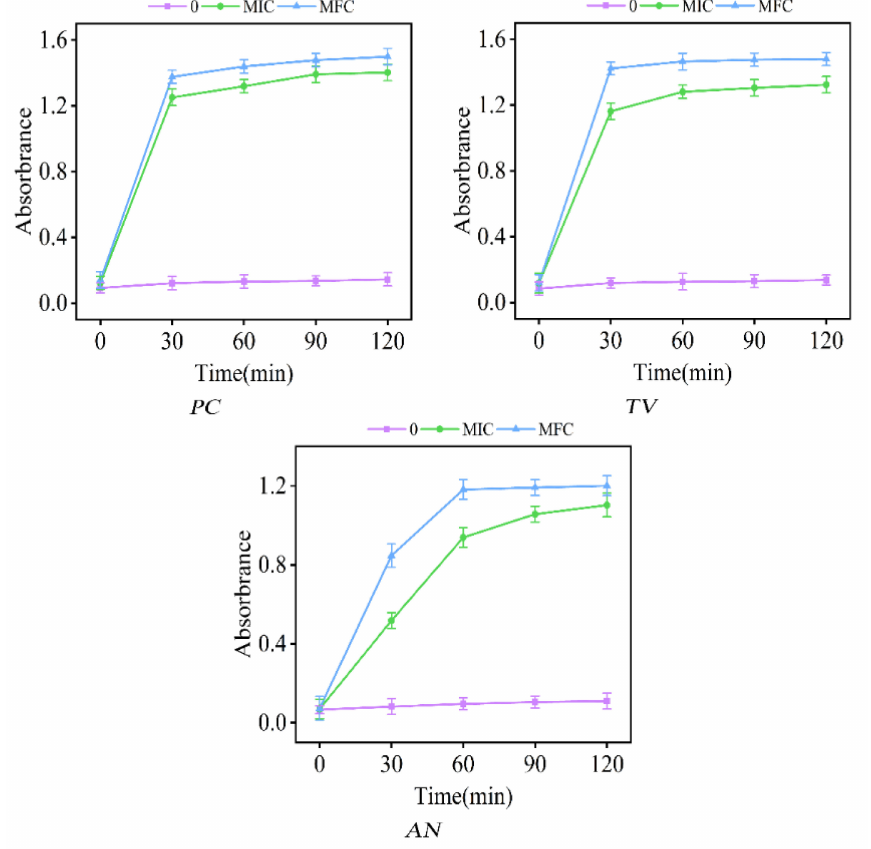
Figure 7. Effect of dodecylpyridinium chloride on the absorbance of 260 nm of the extracellular fluid of bamboo mycorrhizal fungi (control: 0; treated group: MIC,